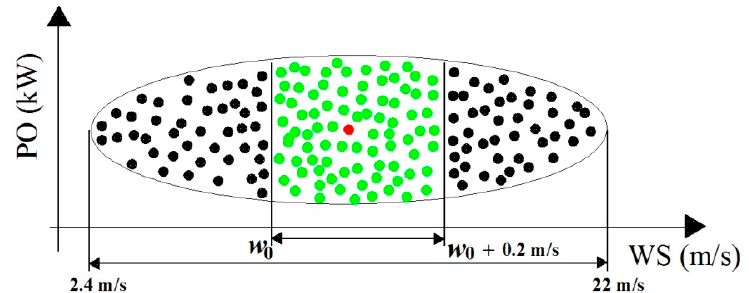
Figure 4. (cid:1835) (cid:2868)(cid:3037) : Intersection of (cid:1875) = (cid:4670)(cid:1875) (cid:2868) , (cid:1875) (cid:2868) + 0.2(cid:1865) (cid:1871)⁄ (cid:4671) with (cid:1835) (cid:2868) = (cid:4670)2.4(cid:1865) (cid:1871)⁄ , 22 (cid:1865) (cid:1871)⁄ (cid:4671) . Most significant point of (cid:1835) (cid:2868)(cid:3037) : Red o; Points of (cid:1835) (cid:2868)(cid:3037) : {Red o, Green o}; Points of the interval (cid:1835) (cid:2868) : {Black o, Green o, Red o}. PO: Power Output. WS: Wind Speed.